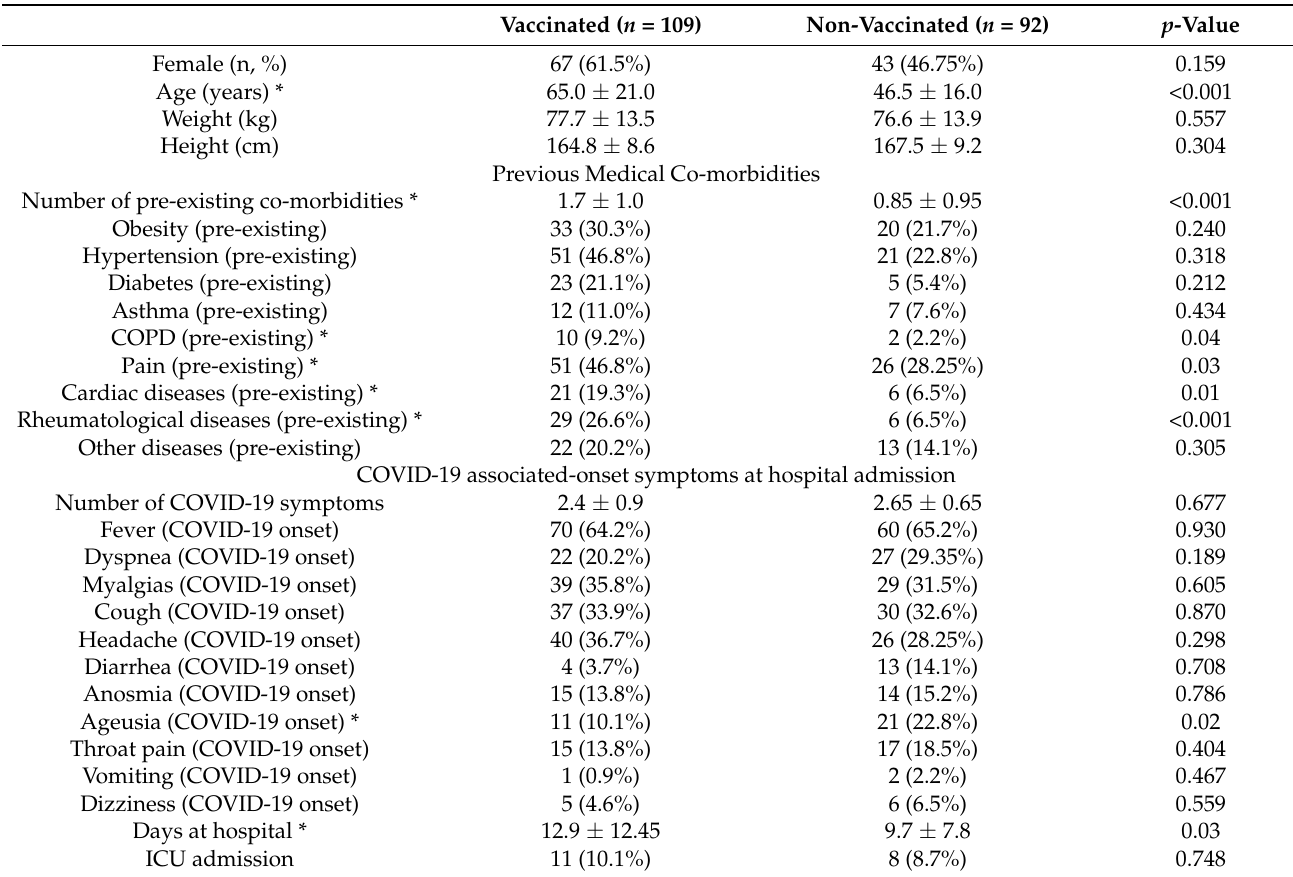
Table 1. Clinical and Hospitalization Data according to Vaccine Status.